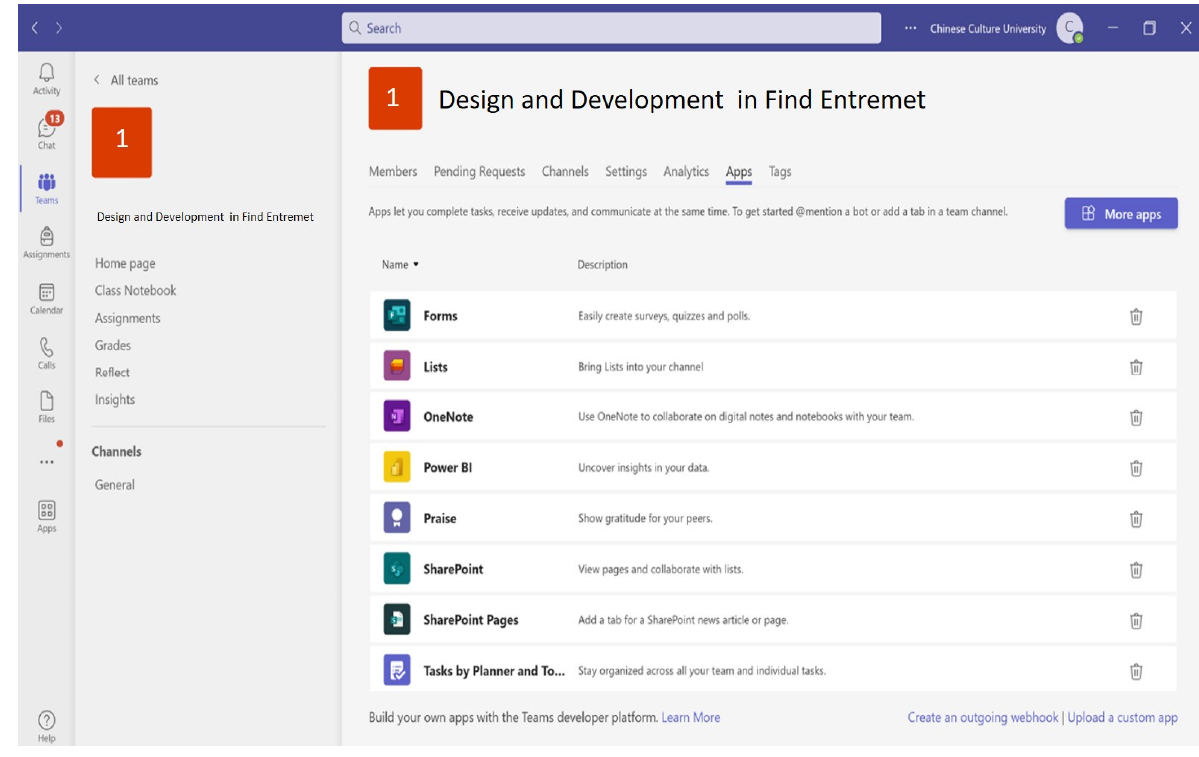
Figure 1. Microsoft Teams System.